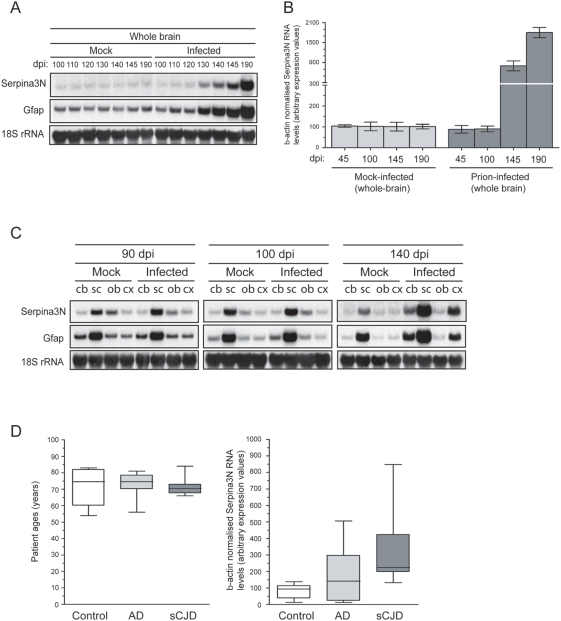
Serpin-a3n/α1-ACT transcripts in brain during prion pathogenesis.(A) Northern hybridization analysis of Serpin-a3n RNA expression levels in whole brains of mice throughout pathogenesis following intraperitoneal inoculation with either mock inoculum or inoculum containing 6 log LD50 RML5 mouse prions (dpi; days post-inoculation). For comparison, expression levels of Glial fibrillary acidic protein (Gfap) RNA are also shown. Expression levels were normalized to 18S rRNA levels. Differential expression of Serpin-a3n transcripts is evident between 120 dpi and 130 dpi in whole brain. For comparison, increased RNA levels of Gfap, traditionally thought of as one of the largest gene expression changes during prion pathogenesis, is evident between 120 dpi and 130 dpi and rises to approximately 8-fold by 190 dpi. (B) DNAse-treated total RNA was prepared from whole brains of mock- or prion-inoculated mice at 45, 100, 145 or 190 dpi and used for qPCR analyses. Serpin-a3n RNA levels are progressively elevated in brains of prion infected mice throughout pathogenesis and at 145dpi and 190 dpi are approximately 9-fold and 17-fold higher compared to mock inoculated controls. Murine measurements encompass a total of three biological replicates. All transcript levels were normalized to beta-actin and expressed relative to mock-inoculated mice or non-neurodegenerative controls. In the murine model of prion disease utilized, terminal signs are evident at approximately 200–210 dpi. Error bars represent standard deviations of three biological replicates. (C) Northern hybridization analysis of Serpin-a3n and Gfap in CNS areas of prion infected and uninfected mice at 90 dpi, 100 dpi and 140 dpi stages of pathogenesis. Equivalent loading of RNA is indicated by 18S rRNA levels. Abbreviations: Cb, cerebellum; Sc, spinal cord; Ob, olfactory bulb; Cx, cortex. Cystatin F differential expression in prion infected mice is first evident in the spinal cord between 90 dpi and 100 dpi (8-fold increase). By 140 dpi, Sepina3n RNA levels in spinal cord, cerebellum and cortex are approximately 6-fold, 3-fold and 5-fold respectively. For comparison, by 140 dpi, Gfap RNA levels, an indicator of gliosis, in spinal cord, cerebellum and cortex are approximately 3-fold, 4-fold and 4-fold respectively. No change in expression levels of these transcripts in olfactory bulb at any of the stages of pathogenesis analyzed here. (D) DNAse-treated total RNA was prepared from occipital cortex obtained at autopsy from patients suffering from non-neurodegenerative diseases (Control), Alzheimer's disease (AD), or sporadic CJD (sCJD) patients. Left panel: Age distribution of the patients in each group at time of death. Right panel: box and whisker plots indicating upper- and lowermost values with mean and 75th percentile for eight patients within each group. Values were tested for statistical significance using Student's t test (two samples, equal variance). Triplicate qPCR reactions were performed for each sample.